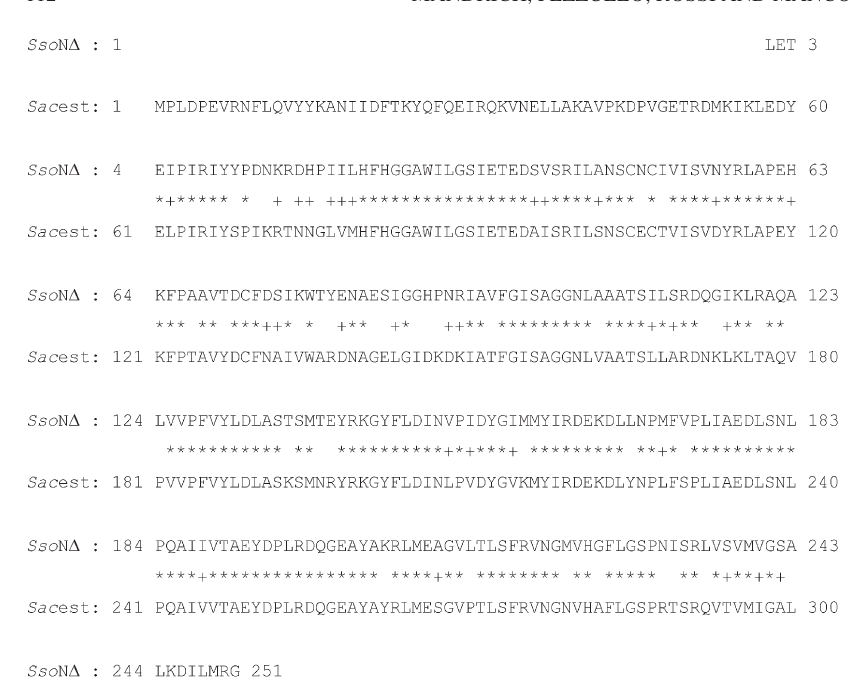
Figure 2. Sequence alignment of Sso N Δ and the putative esterase SAC1105 from S . acidocaldarius .